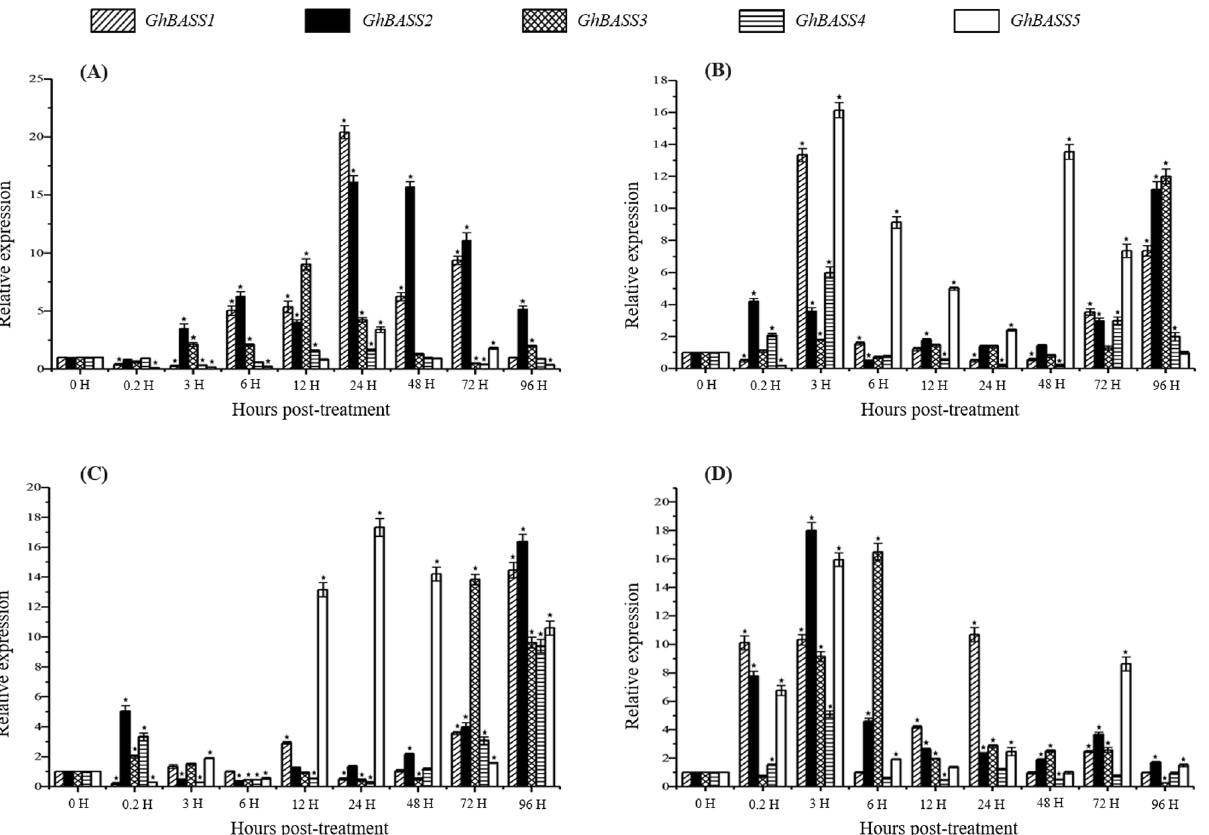
Figure 7. Expression patterns of GhBASSs under different abiotic stresses. ( A ) Expression levels of GhBASSs in cotton roots responded to the salt (NaCl) treatment. ( B ) Expression profiles of GhBASSs in cotton roots after treating with drought (PEG6000). ( C ) Transcript levels of GhBASSs in cotton leaves against heat stress (37 °C). ( D ) Expression patterns of GhBASSs in cotton leaves exposed to cold stress (4 °C). Expression levels were analyzed by qPCR and normalized to the GhUBQ7 gene (GenBank accession no. DQ116441). Means and standard deviations were based on three independent biological replicates. Error bars represent the variation among three independent biological replications. Asterisks indicate the significant difference ( * , P = 0.05) from 0 h post-treatment (hpt) by Tukey’s HSD